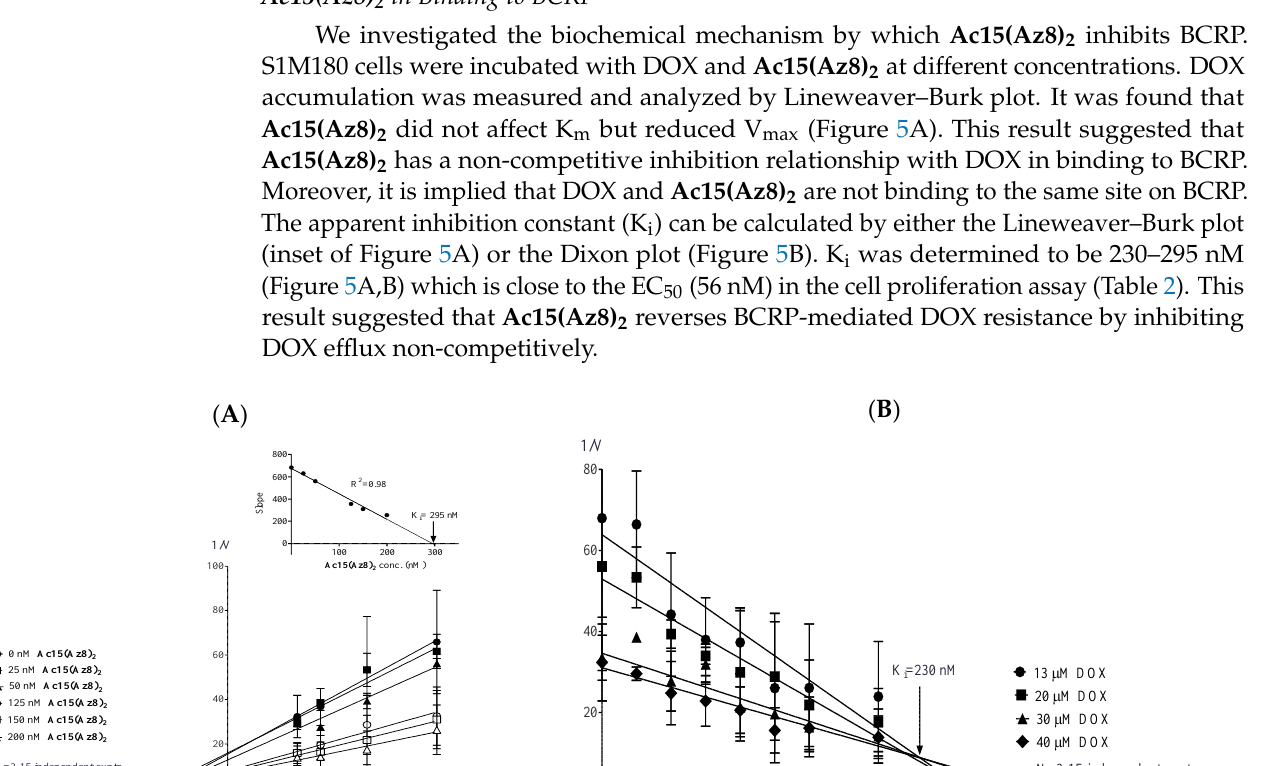
Figure 4. Effect of Ac15(Az8) 2 on surface BCRP protein expression level. ( A ) Cell surface BCRP level of HEK293/pcDNA3.1 and HEK293/R2 cells was measured by flow cytometer using BCRP-FITC antibody. Mouse IgG2b-FITC is an isotype control. ( B ) The surface BCRP level of HEK293/R2 cells was detected after incubating with 1 or 3 µM of Ac15(Az8) 2 for 24 h or 72 h, respectively; 0.3% of DMSO was used as solvent control.